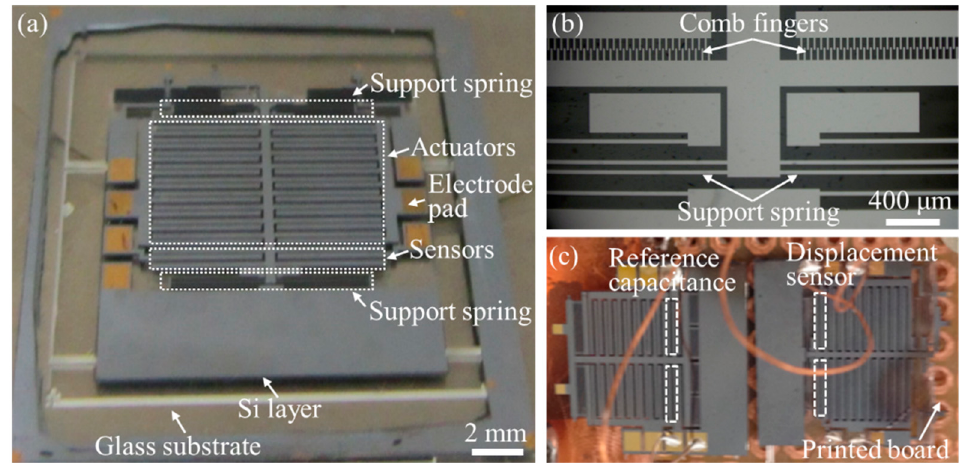
Figure 4. ( a ) Optical image of the fabricated comb-drive actuator (large spring constant type) with the heterogeneous structure of Si anodically bonded onto glass; ( b ) locally enlarged view of the comb fingers and support spring; ( c ) two comb-drive actuators wire-bonded onto a printed board for loading into the cryostat.